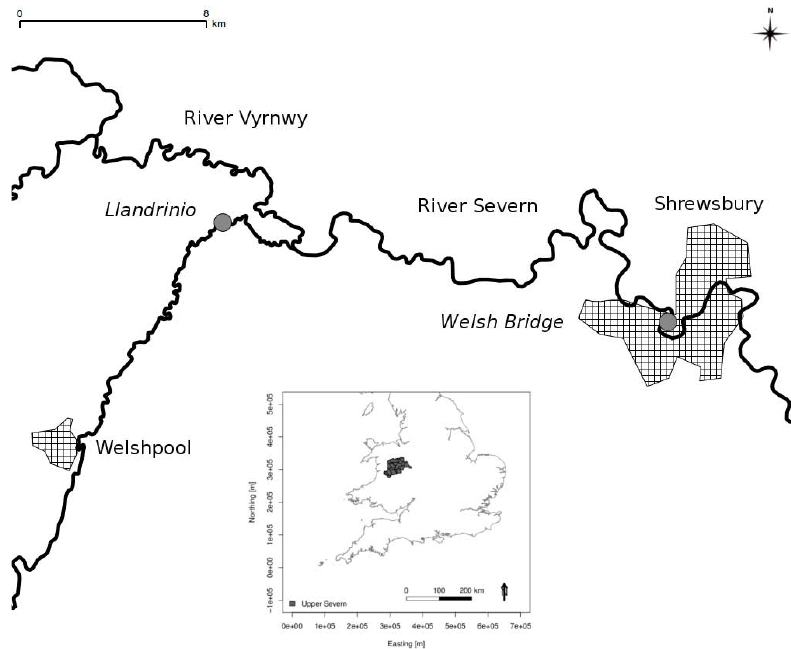
Fig. 1. Schematic map showing the upper River and Vyrnwy tributary which both flow from west to east. Gauged locations considered in the study (circles) and urban areas are shown (hatched). The insert shows the location of the catchment within the UK.